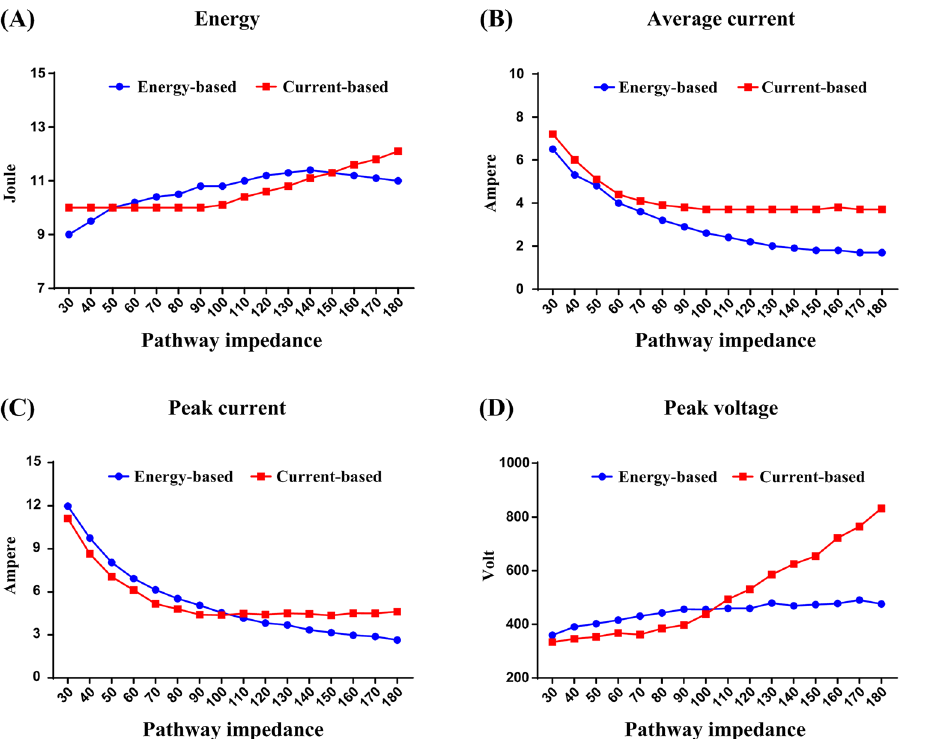
Figure 3. The output energy ( A ), average current ( B ), peak current ( C ), and peak voltage ( D ) value for a 10 J test shock in relationship to the pathway impedance in current-based and energy-based